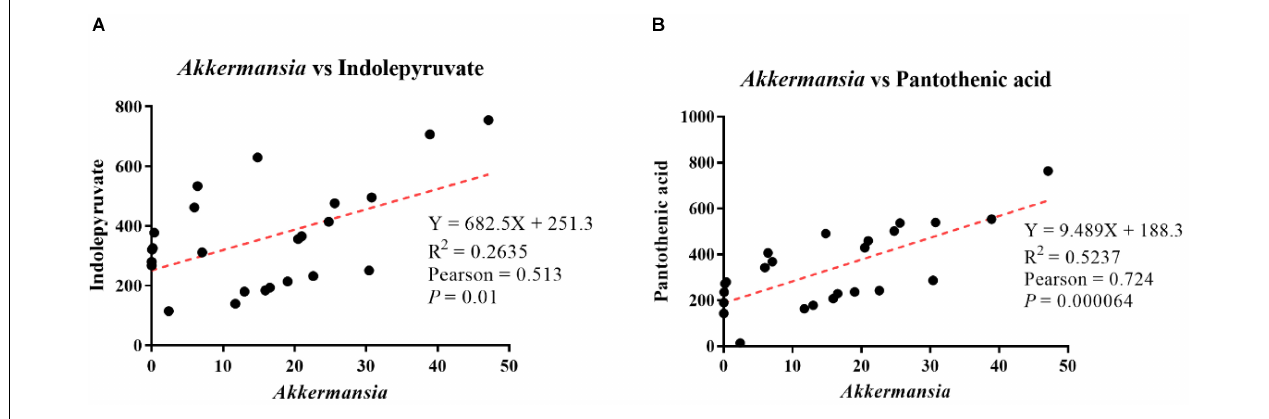
FIGURE 8 | Analysis of correlations between differential metabolite levels and genus-level intestinal microbe abundance. (A) Correlation analysis between Akkermansia abundance and indolepyruvate levels. (B) Correlation analysis between Akkermansia abundance and pantothenic acid